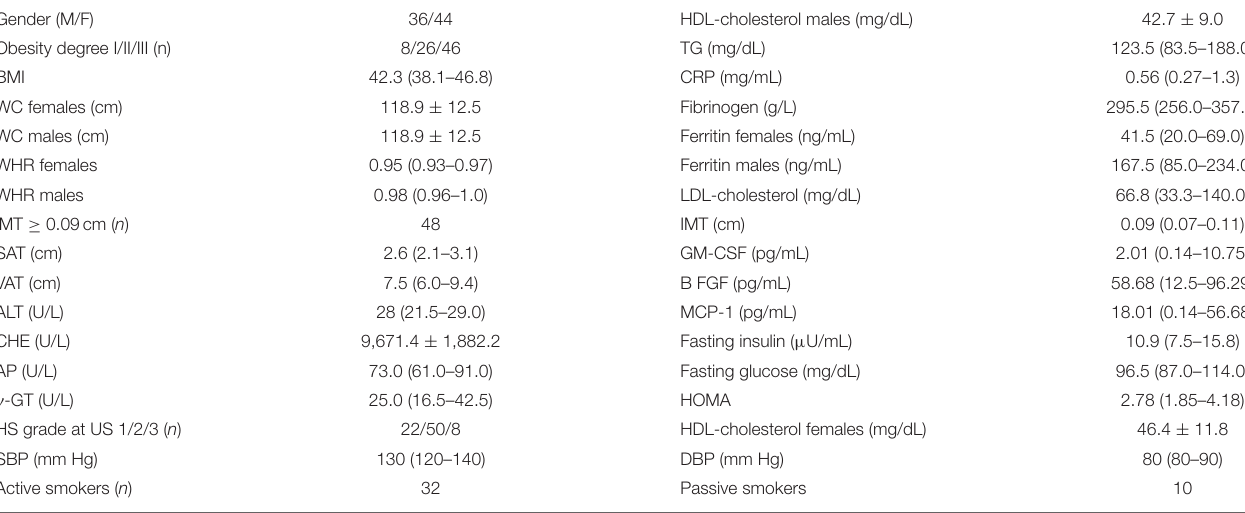
TABLE 1 | Characteristics of the obese patients with NAFLD ( n 80), comprehending the metabolic parameters.